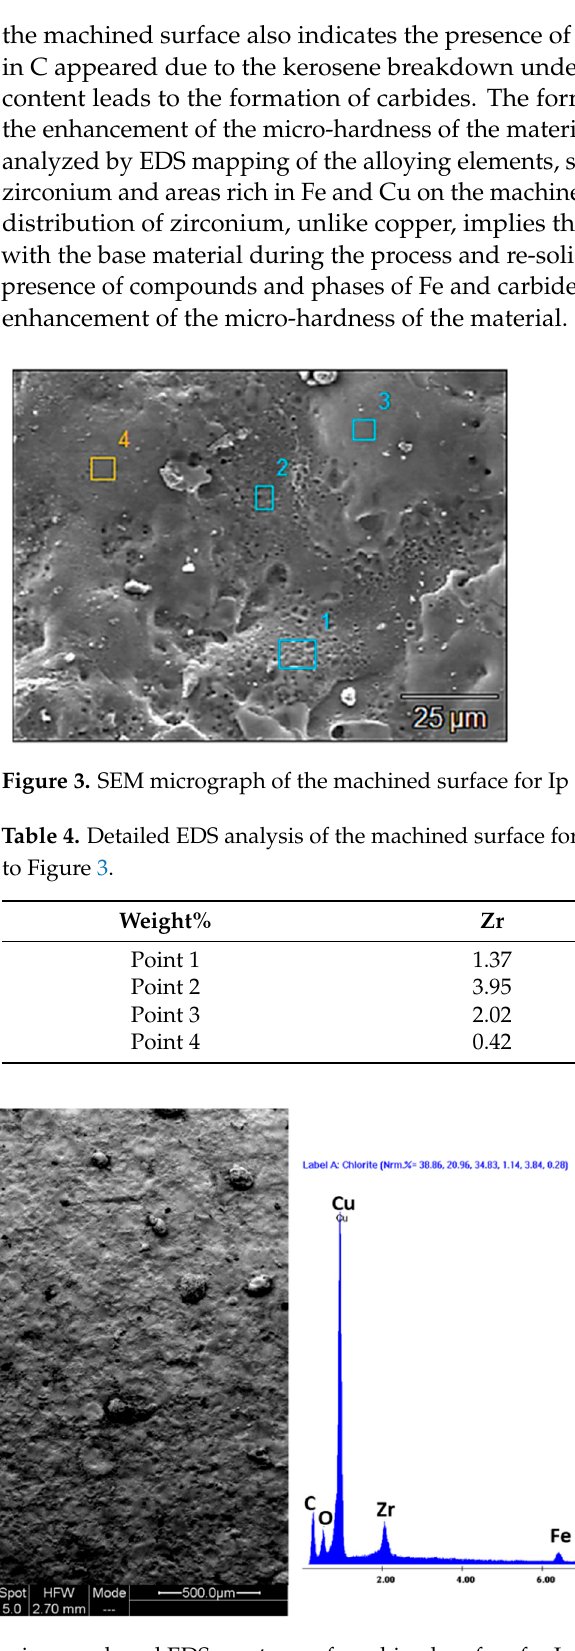
Figure 4. SEM micrograph and EDS spectrum of machined surface for Ip = 5 A and Ton = 25 μ s.